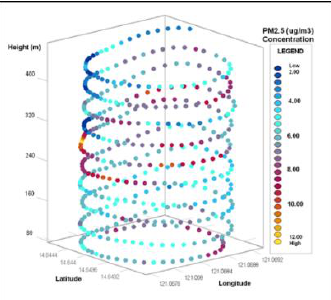
Figure 11. Three-dimensional distribution of PM2.5 (%) on March 22 nd